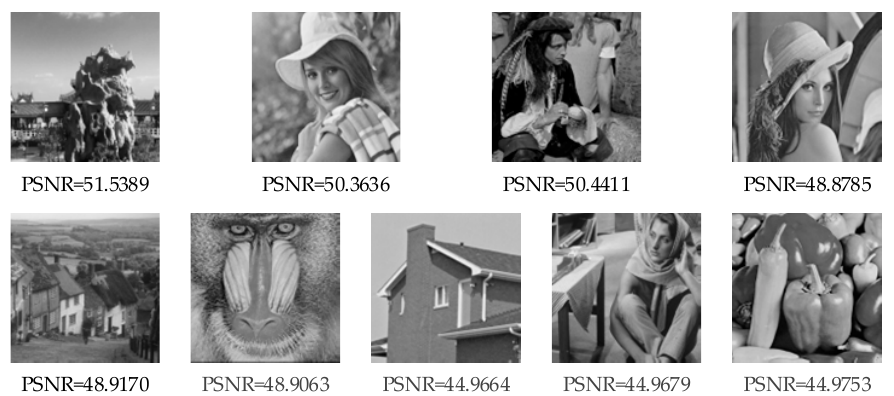
Figure 8. The simulation results of invisibility.